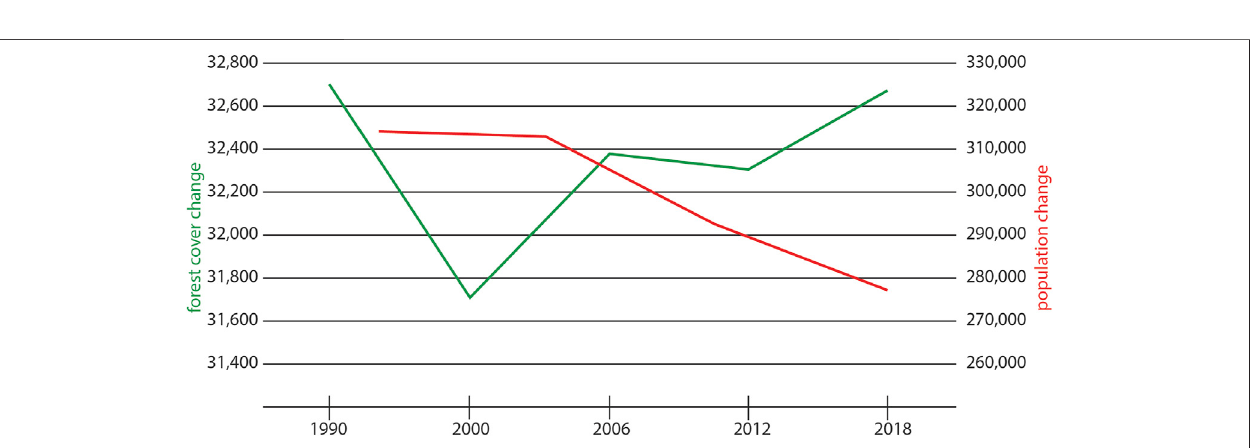
FIGURE7| Acomparativeoverviewofthechangesintheforestcover(1990-2018)andthenumberofinhabitants(1991-2018*).*Estimatednumberofinhabitants.